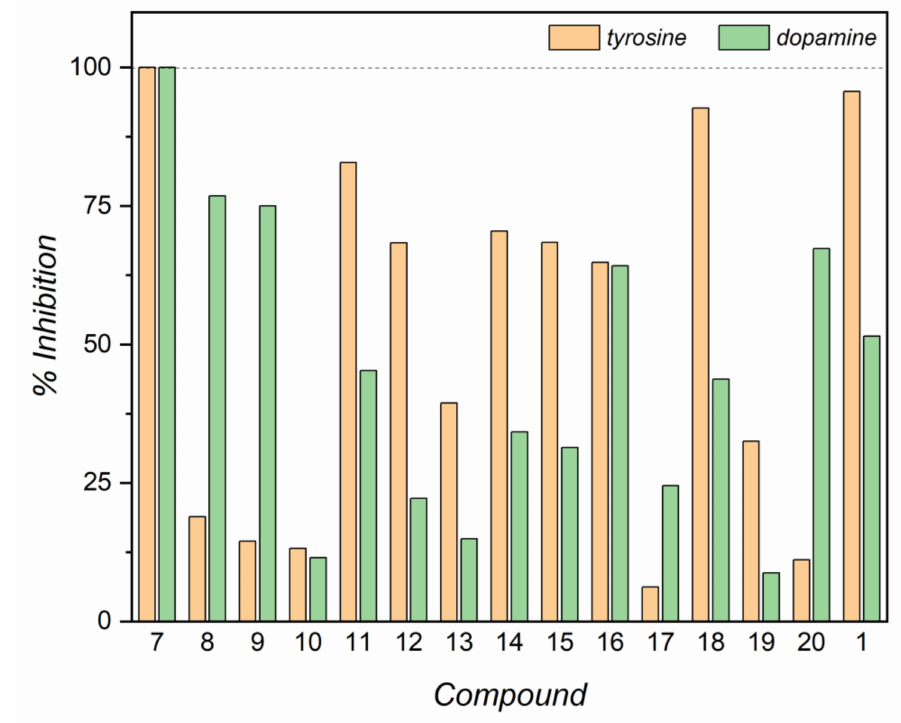
Figure 3. Percentage of tyrosinase inhibition determined by UV-Vis spectroscopy. Tyrosine was dissolved in 50 mM phosphate bu ff er, pH 6.8, final concentration 80 µ M and with the added inhibitor (final concentration 20 µ M) and tyrosinase (83 U / mL). The absorbance values were determined after 24 min of incubation. In the presence of dopamine, experiments were performed using 10-fold diluted solutions, and the absorbance values were determined after 10 min of